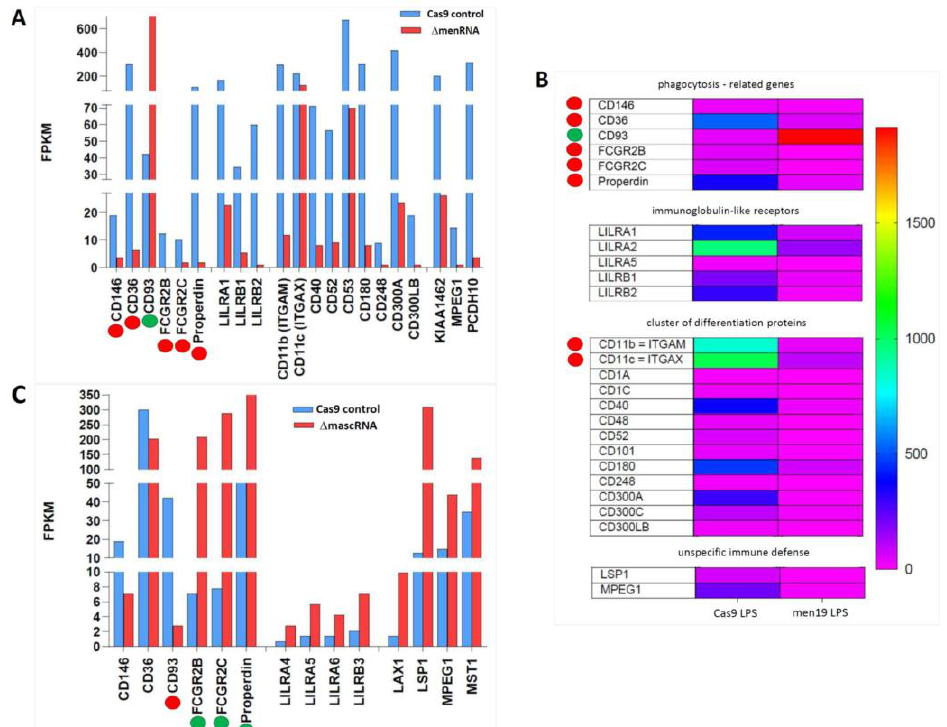
Figure 8. Disturbance of scavenger receptor expression in ∆ menRNA and ∆ mascRNA macrophages. Panels ( A – C ): These changes occur in the context of further anomalies, identified by RNA-seq of monocytes, affecting phagocytosis as an evolutionarily conserved general defense mechanism involving, beyond scavenger receptors, Fc γ receptors (Fc γ Rs) [59,60] and complement receptors (CRs). FCGR2 genes encoding Fc fragments of inhibitory Fc γ RIIB are suppressed in ∆ menRNA cells and not rescuable by LPS (panel ( A , B )). Complement component properdin (CFP) is likewise down. Of note, ∆ mascRNA cells (panel ( C )) display opposed deregulation of the same FCGR2 genes, and induction of properdin and other complement components. Also Remarkable is the strong opposed deregulation of CD93 in ∆ menRNA compared to ∆ mascRNA monocytes. While massively induced in ∆ menRNA cells, CD93 was shut down in ∆ mascRNA monocytes, contrasting with robust expression in controls. CD93 is a lectin receptor involved in control of the immune response [52]. Another distinction between the defective clones regards MPEG-1 (perforin-2), an evolutionary ancient protein involved in the unspecific immune defense [53], which was ~16-fold down in ∆ menRNA but upregulated in ∆ mascRNA cells. Scavenger receptor CD36 [45,47] was ~48-fold down in ∆ menRNA monocytes. They also show suppression of Cluster of Differentiation (CD) marker CD40, a member of the TNF receptor family, and of CD52, a glycoprotein-modulating T-cell activation. CD300A and CD300C, involved in viral immune evasion, were ~26-fold- and ~5-fold-suppressed, respectively. None of the group 1 CD1 molecules, normally expressed on cells specialized in antigen presentation, could be induced by LPS-treatment of ∆ menRNA cells. Finally, leukocyte immunoglobulin-like receptors (LILRs) were broadly deregulated. ∆ mascRNA cells (panel C ) displayed none of these ∆ menRNA-associated CD molecule or LILR deregulations. The color bar asociated with the rainbow plot in panel ( B ) represents FPKM